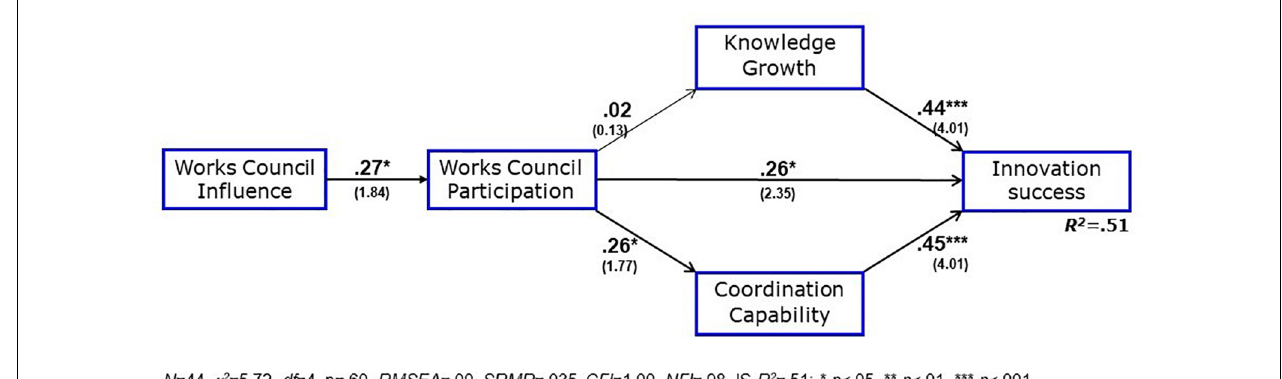
FIGURE 3 | Test of the theoretical model from Figure 1 . Numbers in bold face next to paths are path coefficients, t -values are given in brackets below; R 2 = explained variance.